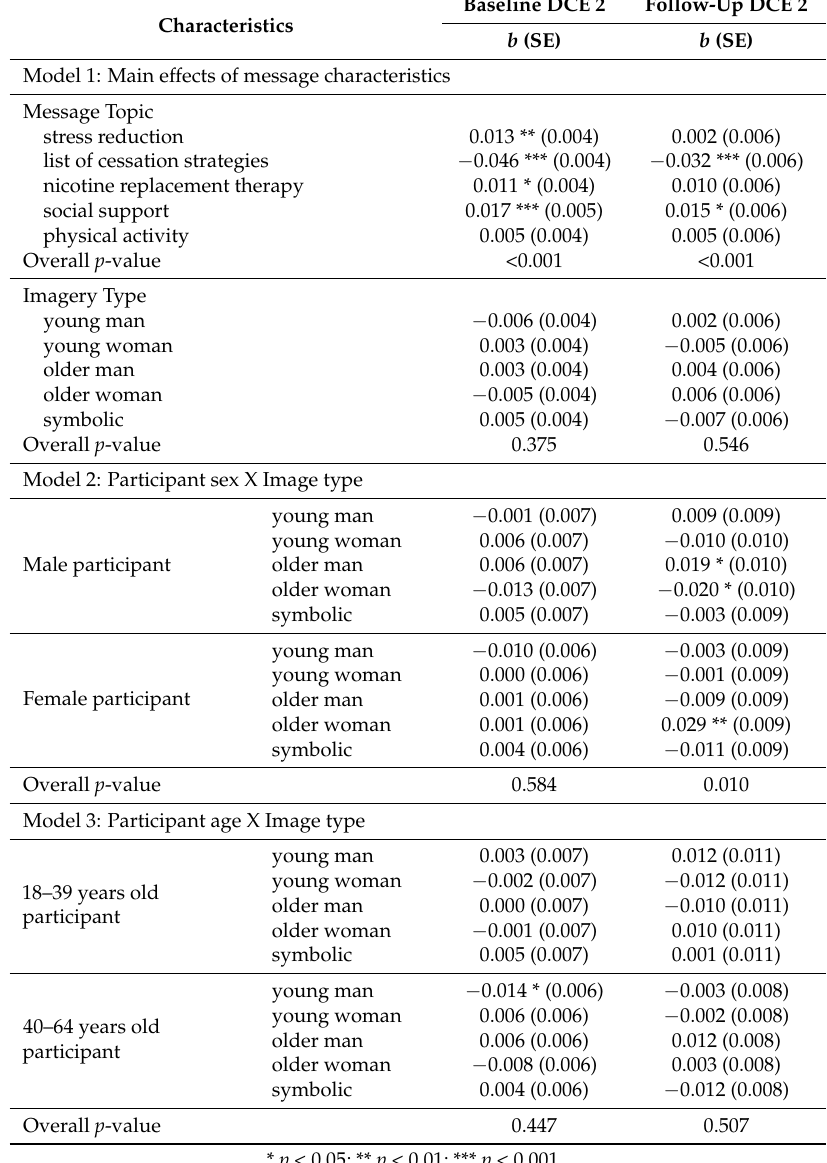
Table 3. Effects of quitting tips message characteristics on helpfulness for